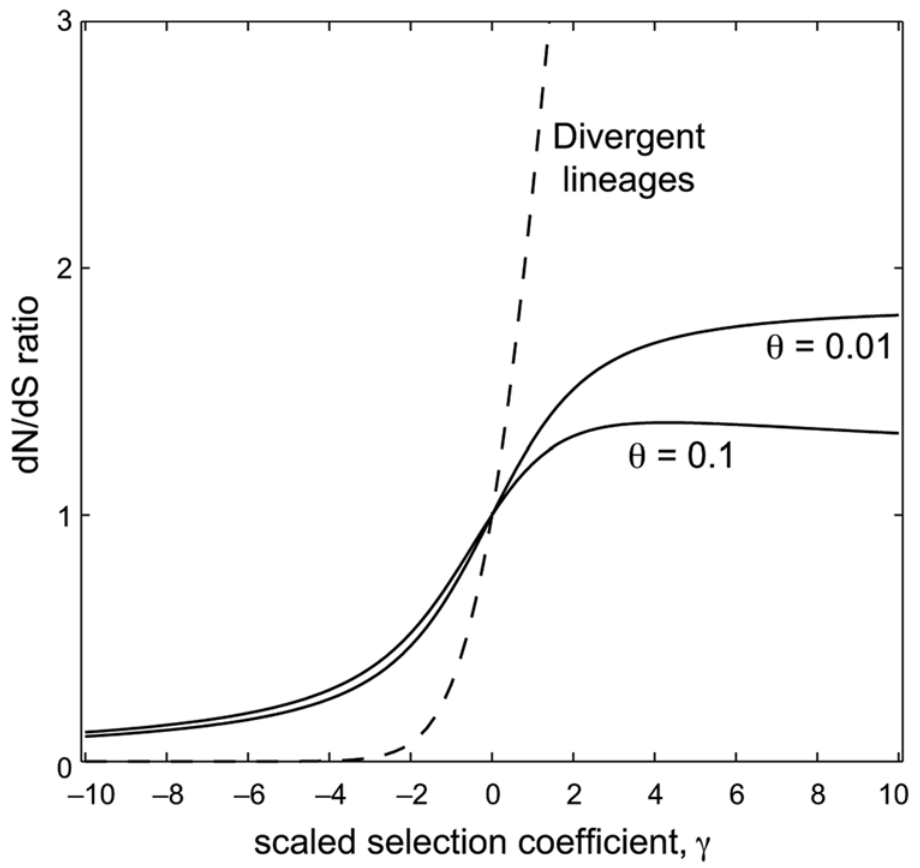
Figure 1. The relationship between the scaled selection coefficient, c , and the expected dN/dS ratio. The dashed line shows the expected dN/dS ratio for samples from divergent lineages, given by Equation (2). The solid lines show the expected dN/dS ratio for within-population samples, given by Equation (5), under two mutation rates.